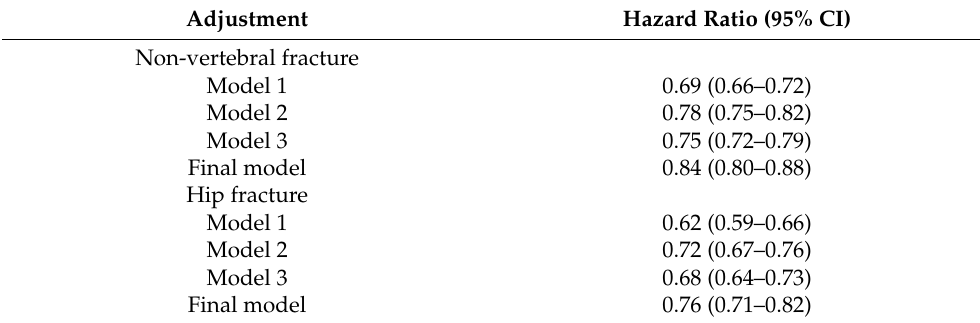
Table 3. Risk of non-vertebral or hip fracture in the gout group compared with the RA